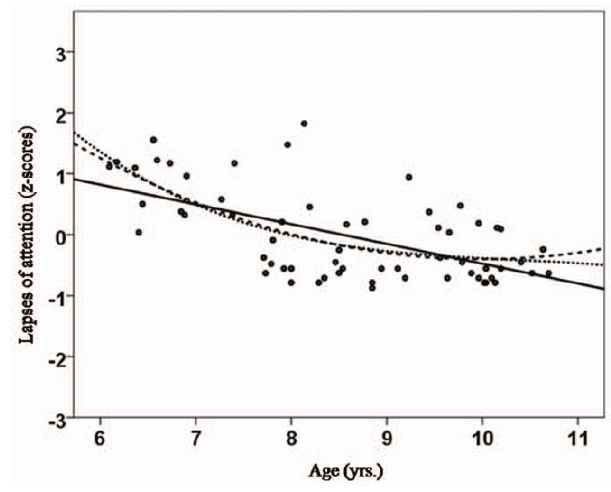
Figure 3. Correlation between age (yrs.) and lapses of attention as assessed by the KITAP [ 18,33 ] . A linear trend was indicative of a reduction of lapses of attention with increasing age; a quadratic trend, but no cubic trend, was indicative of a plateau (decrease – plateau)